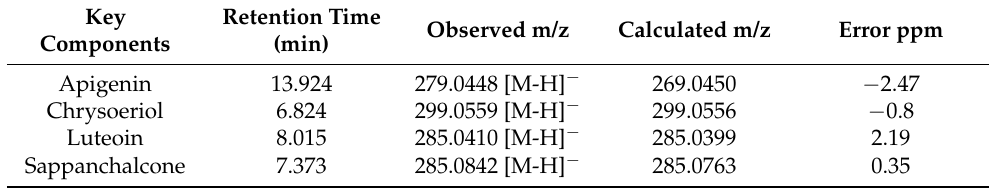
Table 3. List of the key components detected in Dangguisu-san using HPLC-Q-TOF-MS analysis.